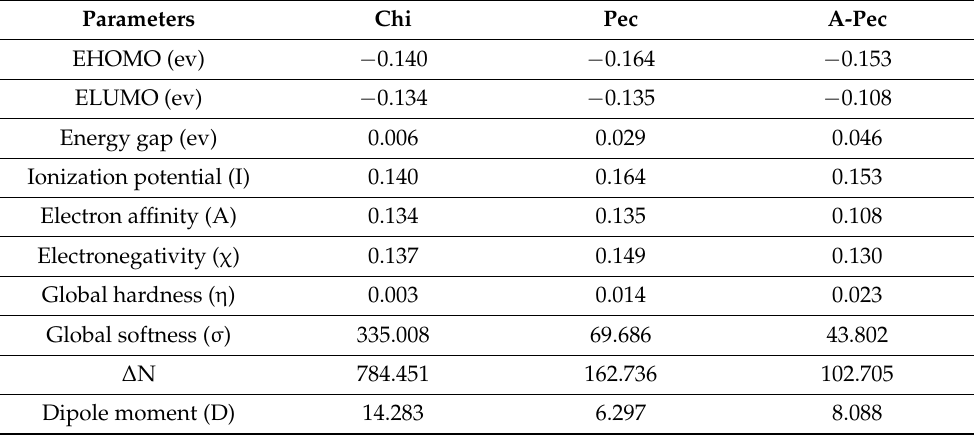
Figure 20. Optimized structure and the frontier molecular orbitals HOMO and LUMO of the tested carbohydrate polymer molecules. carbohydrate polymer molecules. Table 8. Quantum chemical parameters for the tested carbohydrate Table 8. Quantum chemical parameters for the tested carbohydrate polymers.